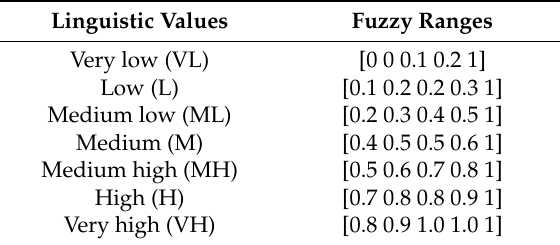
Table 3. Linguistic terms for ranking the criteria.